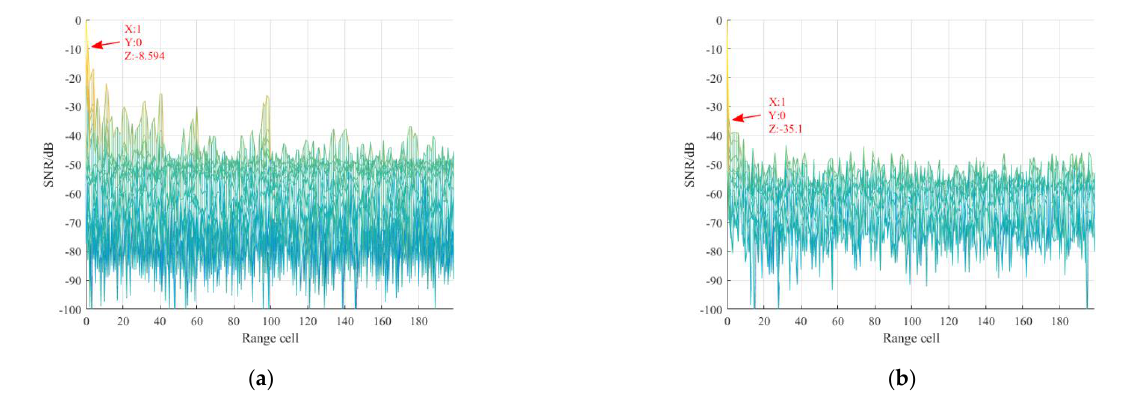
( b ) Figure 12. Geometry of the experiment: ( a ) the real geometric model; ( b ) the analytical model.